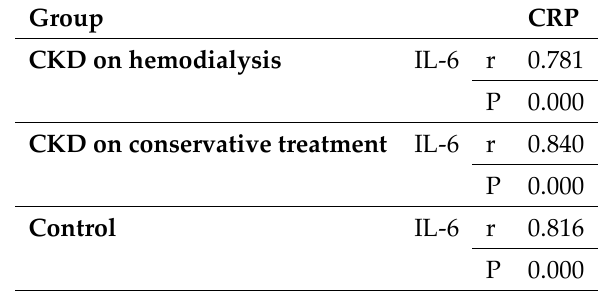
Table 7: Correlation between salivary IL-6 and CRP in CKD patients and control